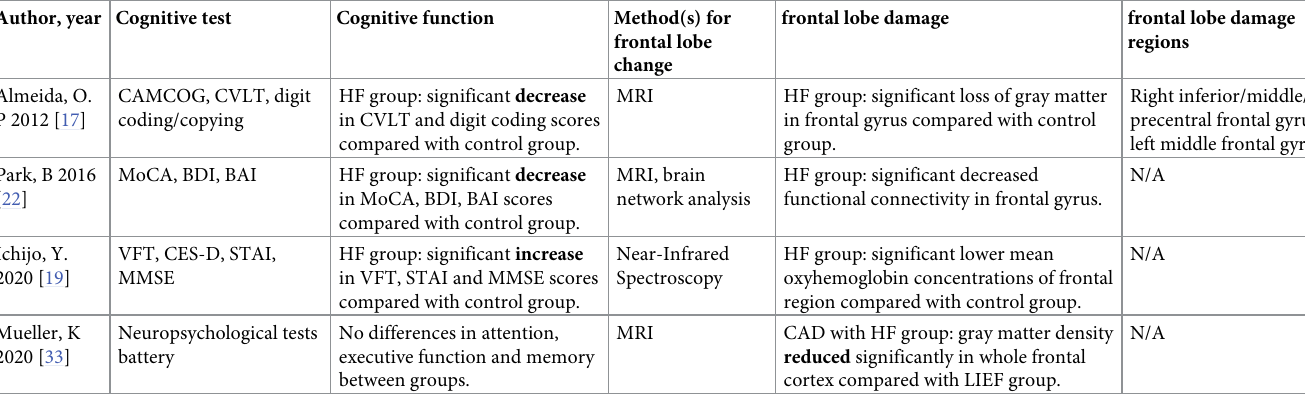
Table 8. Characteristics of cognition and changes of frontal lobe in clinical